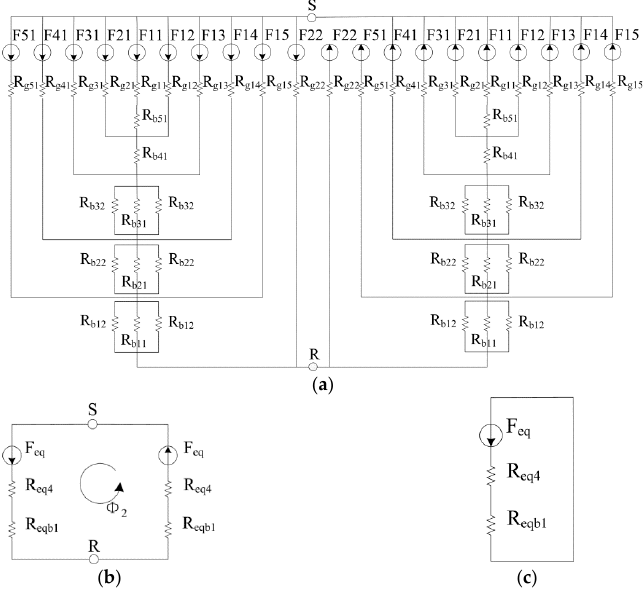
Figure 4. ( a ) MEC for the proposed motor; ( b ) Simplified equivalent circuits of ( a ); ( c ) Final simplified equivalent circuits of SynRM with proposed rotor structure MEC for a SynRM with cross-shaped flux-barriers.